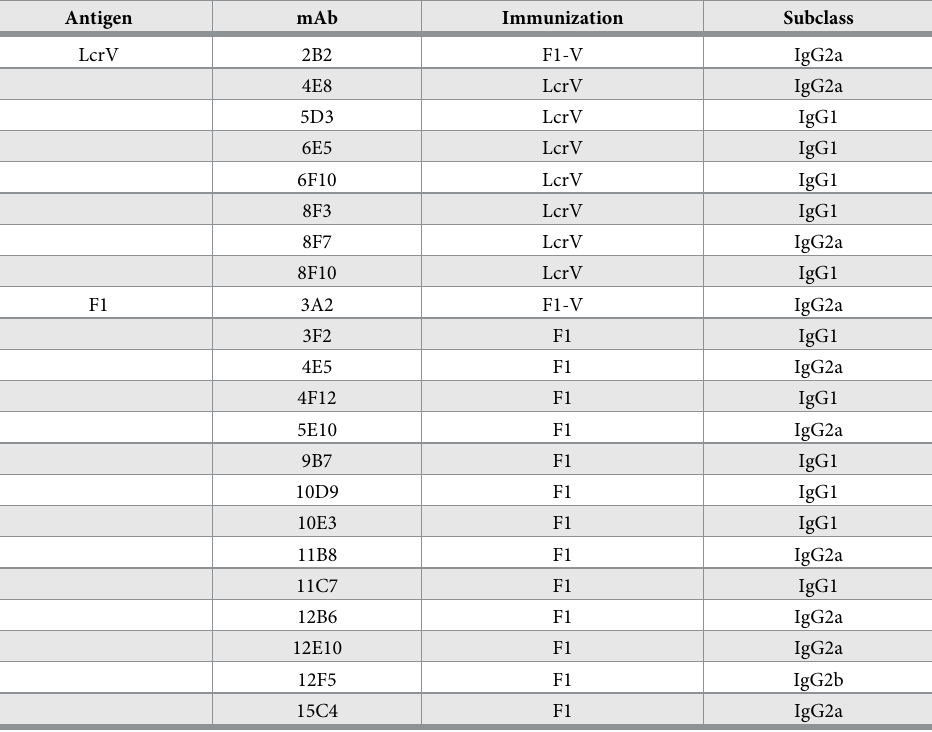
Table 1. Monoclonal antibody (mAb) library against Y . pestis LcrV and F1